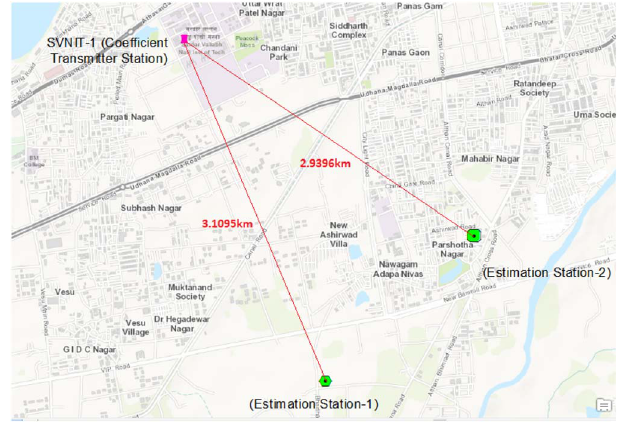
Fig. 5. Station physical location